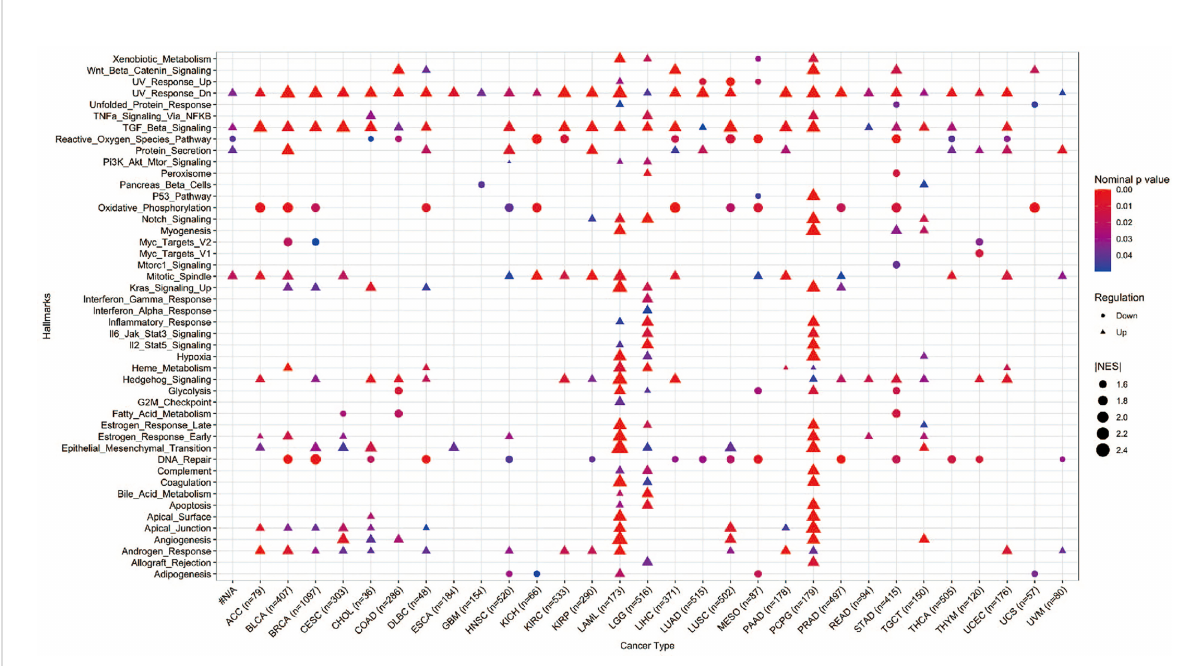
FIGURE 6 GSEA of hallmarks in cancer patients with high YAP1 expression versus those with low YAP1 expression. Only statistically signi fi cant hallmarks (p < 0.05) were